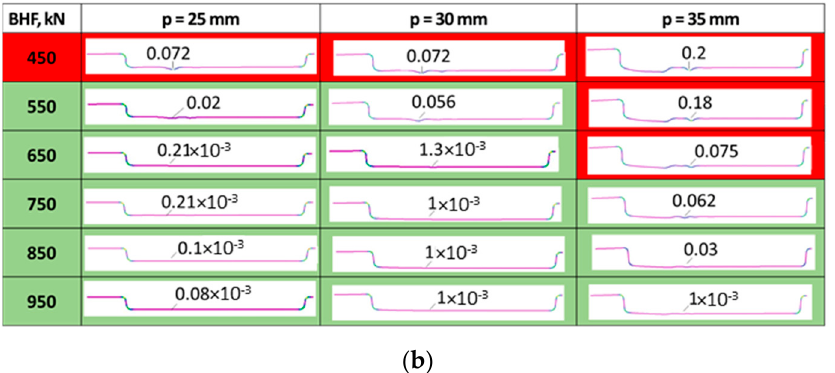
Figure 11. Graphical scheme of the combination of BHF and p parameters which assure/do not assure the threshold values for ( a ) thinning and ( b ) curvature.